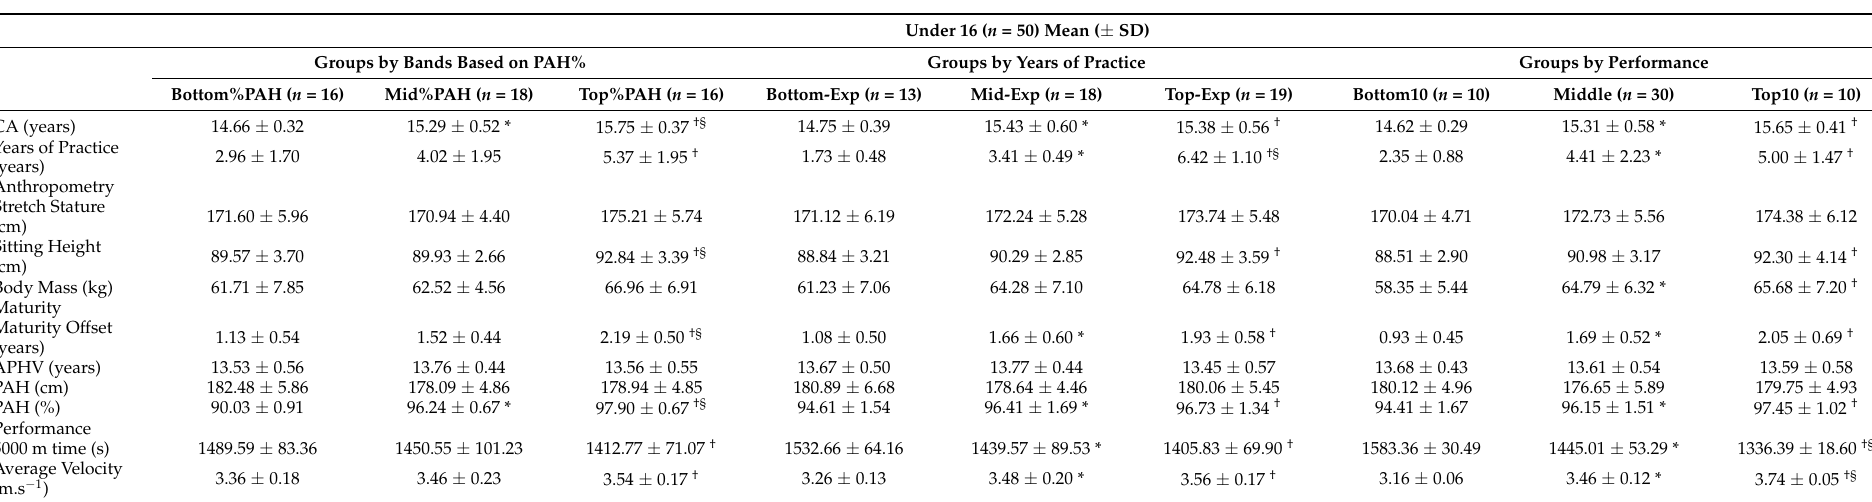
Table 3. Mean ( ± SD) for chronological age (CA), years of practice, anthropometry, maturity, and performance parameters for bands based on the percentage of predicted adult height (Bottom%PAH, Mid%PAH, and Top%PAH), grouped by years of practice (Bottom-Exp, Mid-Exp, and Top-Exp), and grouped considering performance (Top10, Middle, and Bottom10) for under 16